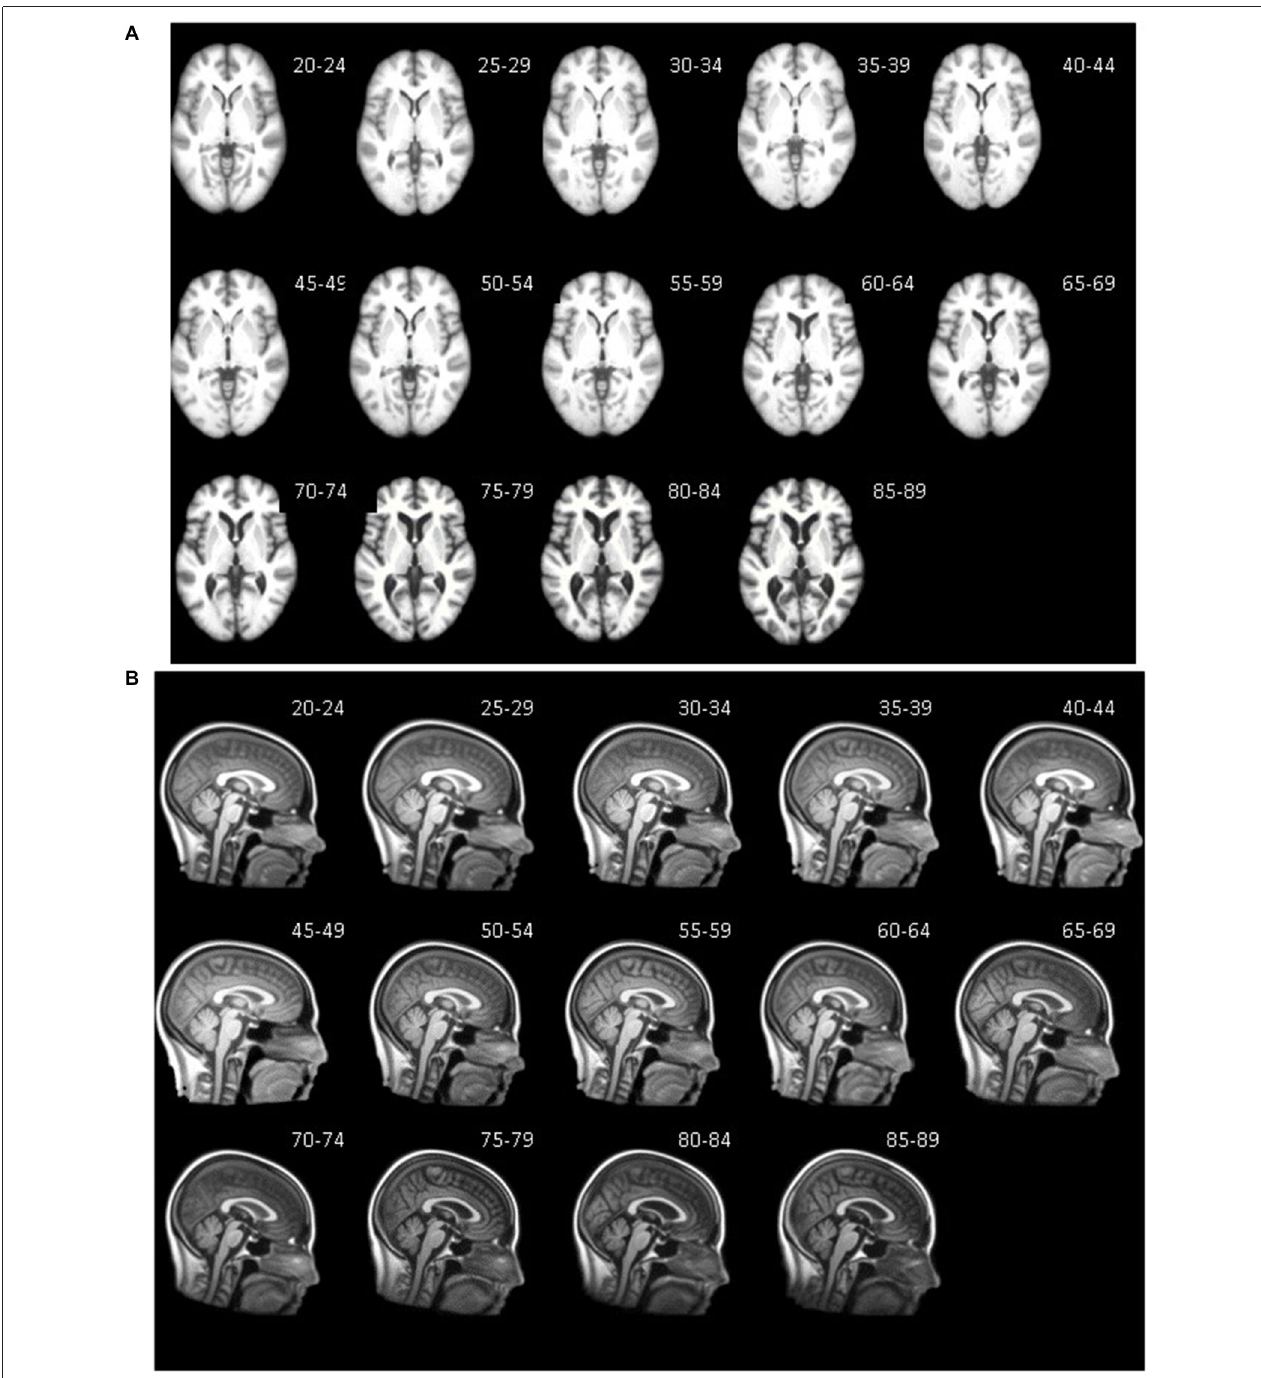
FIGURE 3 | Age-specific templates showing axial slice at AC-PC commissure (A) of brain extracted average template and mid-sagittal slice (B) of whole head average template . T1W MRI volumes across ages of study.